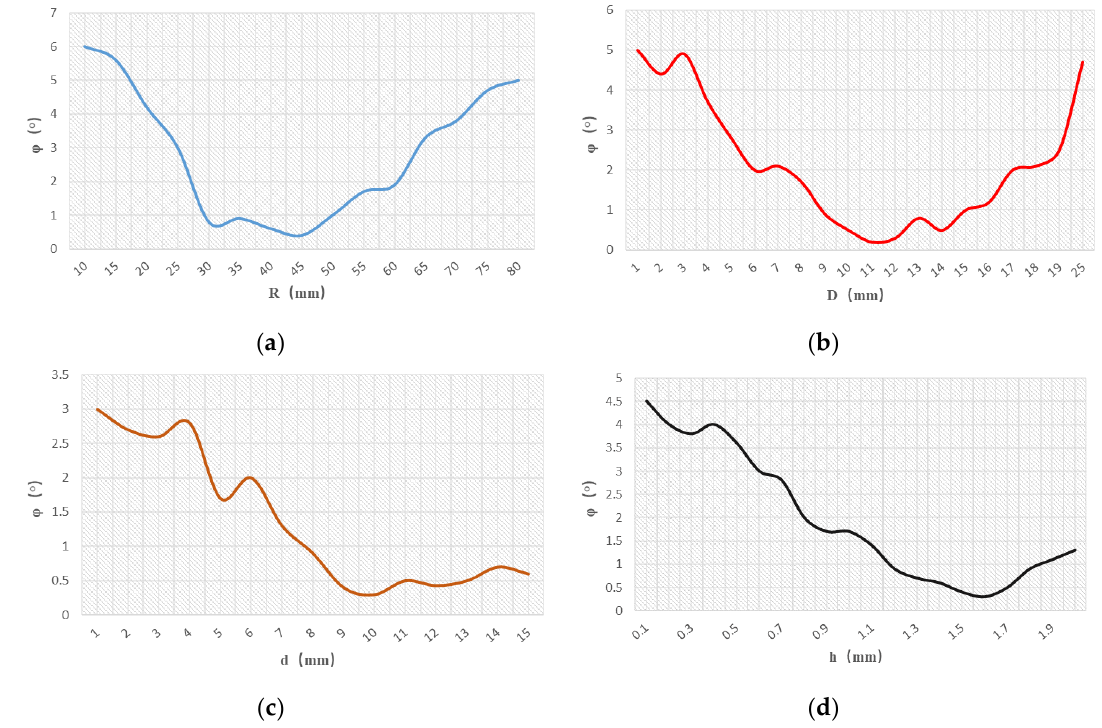
Figure 7. Characteristic curves of sensor parameters and phase difference: ( a ) R- ϕ . ( b ) D- ϕ . ( c ) d- ϕ . ( d ) h- ϕ .